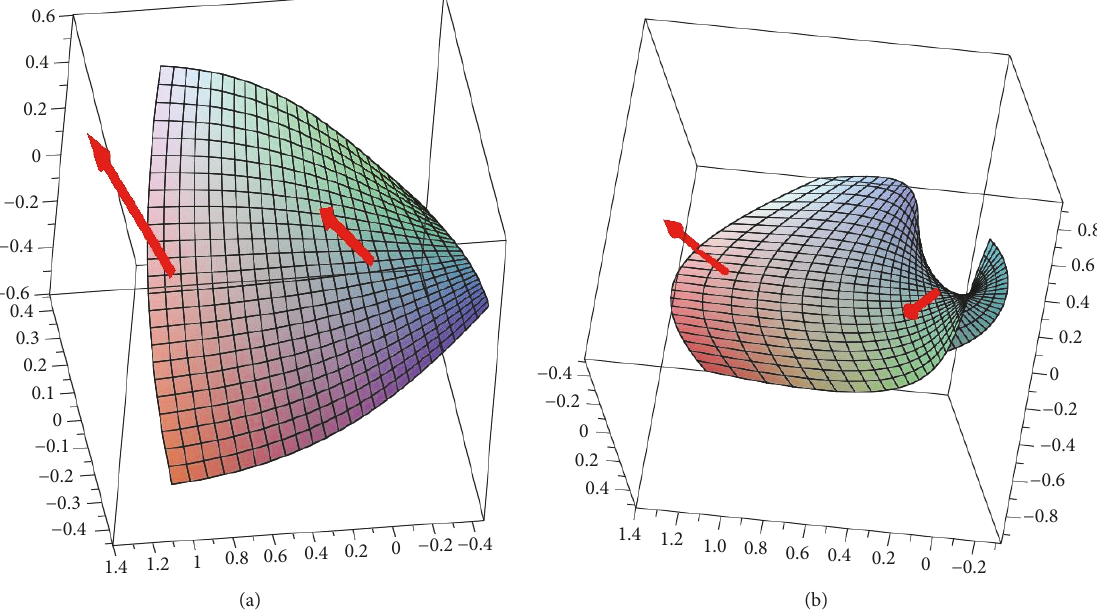
Figure 2: Two s-Enneper surfaces satisfying 𝐻 1 𝐶 in Example 11: (a) the s-Enneper surface Σ 𝜆 1 that satisfies 𝐻 1 𝐶 when 𝑢 0 = (−1 + √5)/2 and 𝜆 = (21 + 15√5)/38 ; and (b) the s-Enneper surface Σ 𝜆